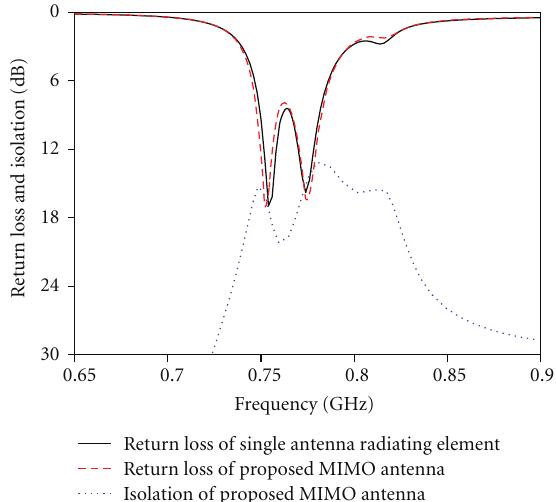
Figure 2: Return loss and isolation characteristics of a single anten- na element and the proposed MIMO